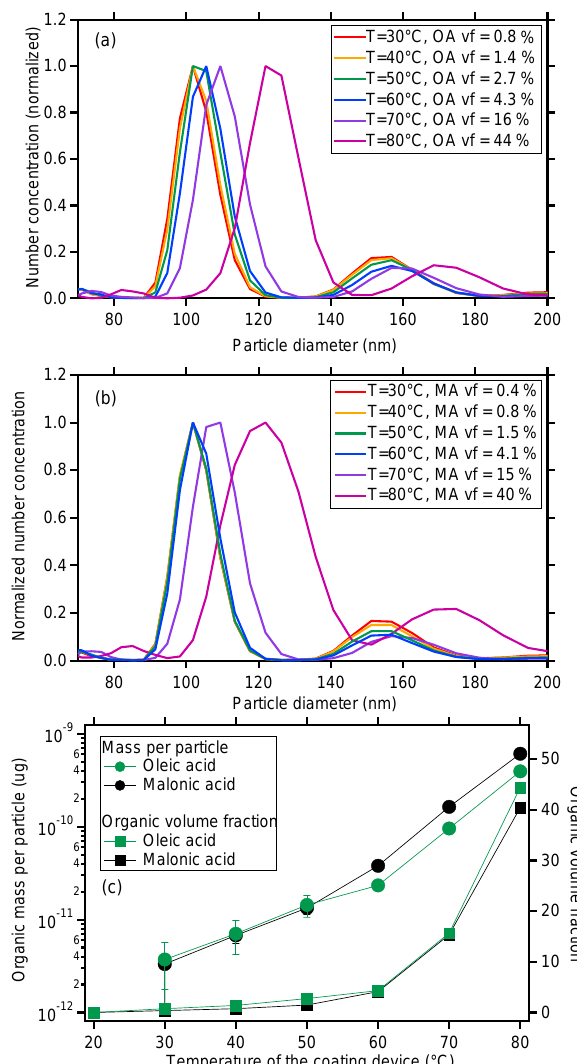
Figure 3. Size distribution of monodisperse CaCO 3 aerosol parti- cles after coating with oleic acid (a) or malonic acid (b) . Coating amount and organic volume fraction for oleic and malonic acid as a function of the coating temperature for the same experiments ( c , data in Table